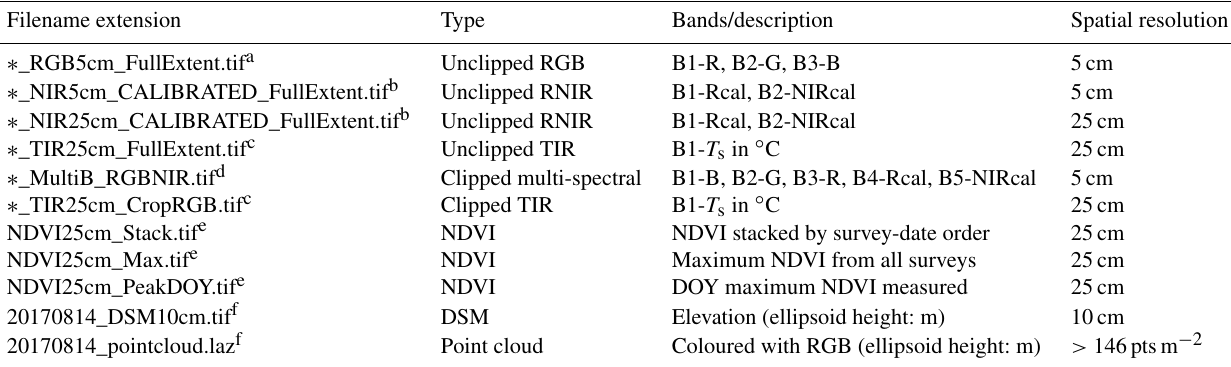
Table 2. Summary of available datasets and filename extensions as provided on the EDI